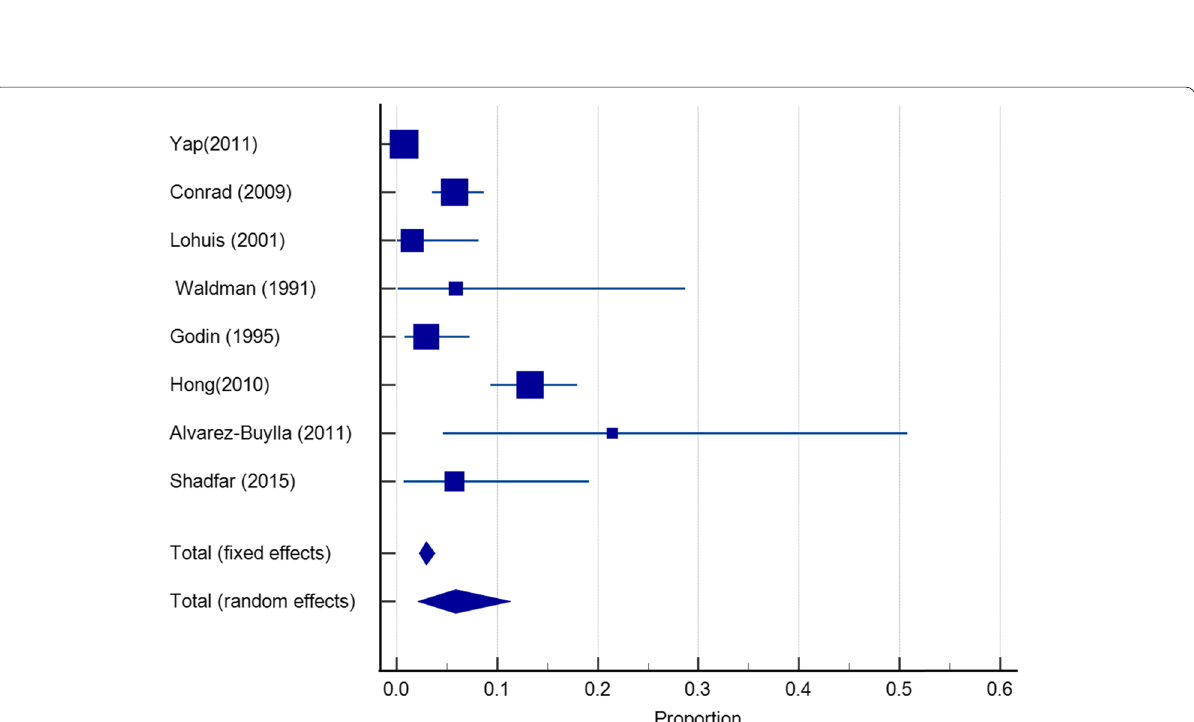
Fig. 10 Revision rates reported for Gore-Tex in both fixed and random-effects